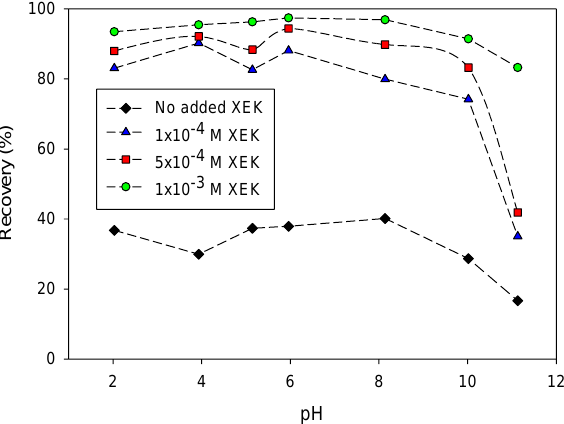
Figure 17. Flotation recovery of pyrite as a function of pH in the presence of various additions of potassium ethyl xanthate (adapted from Cabrera Tejeda [48]).